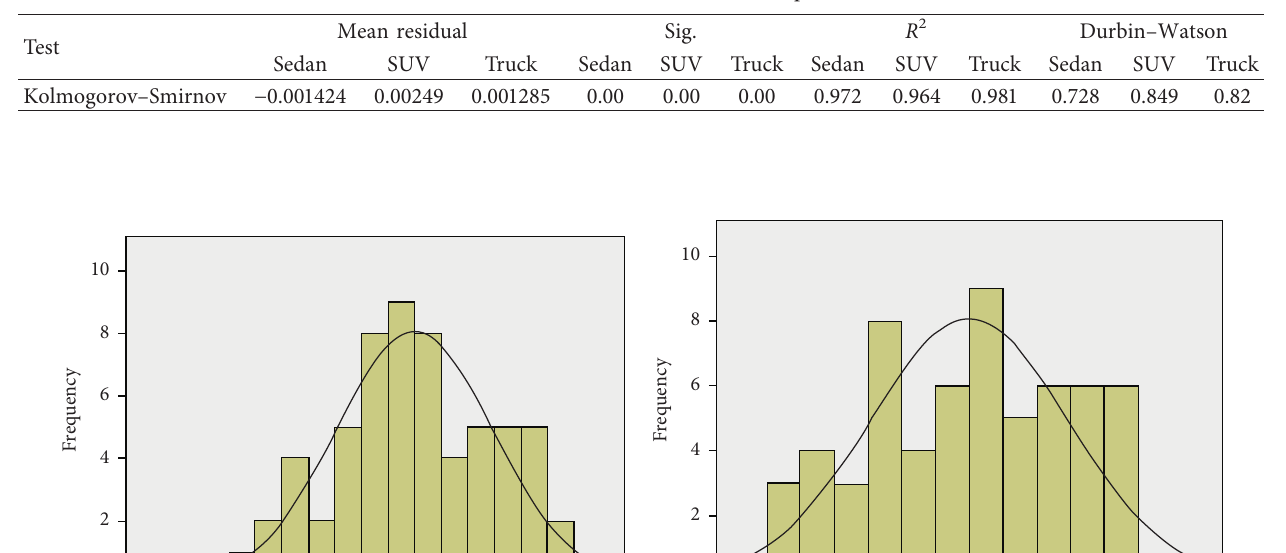
Table 2: Statistical results of the maximum lateral acceleration in the simple horizontal curve for various vehicles.